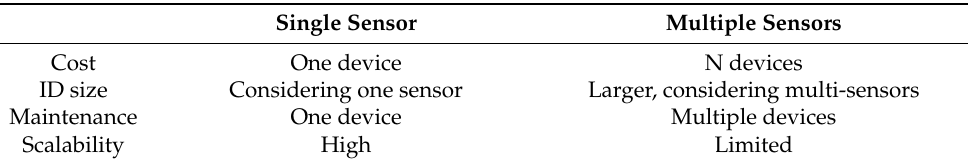
Table 1. Comparison in terms of cost, size, maintenance, and scalability between a single sensor and multiple sensors.